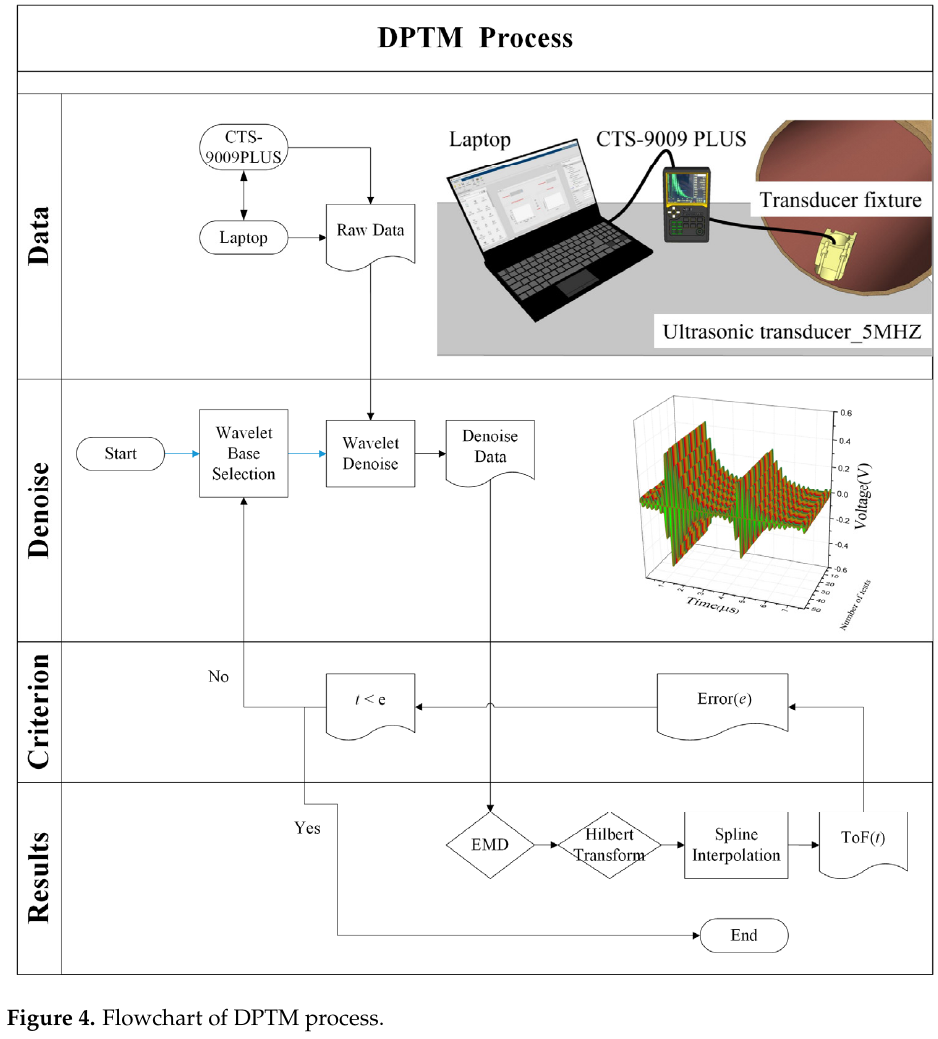
Figure 4. Flowchart of DPTM process.